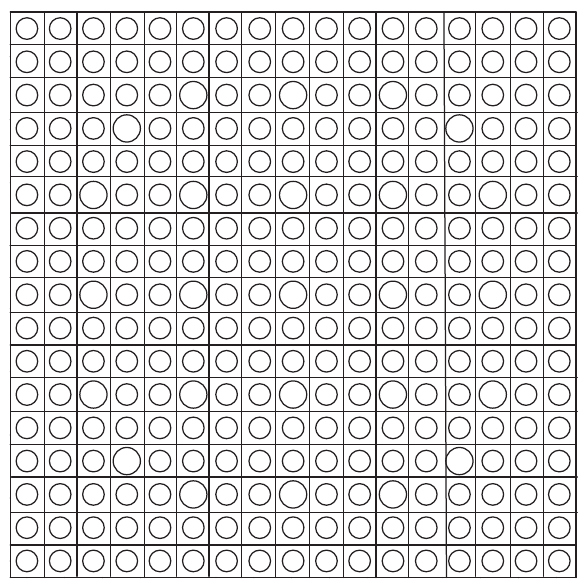
Figure 1: Westinghouse 17 × 17 PWR lattice